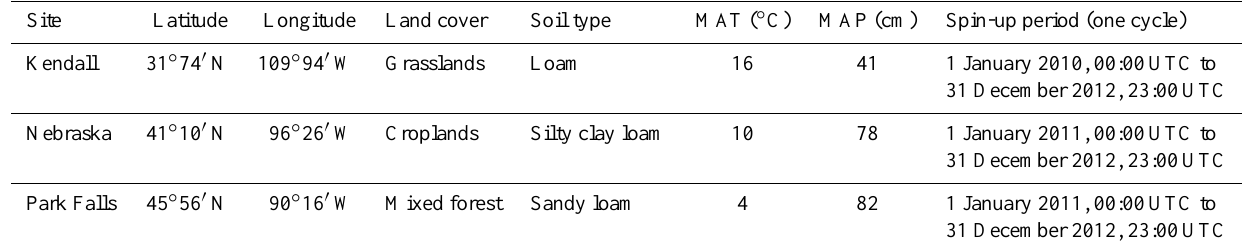
Table 1. Site information obtained from AmeriFlux database (http://ameriflux.lbl.gov). MAT = mean annual temperature, and MAP = mean annual precipitation. Notice the analyzed period in this study is a subset of the available data from each site and it is defined from 1 May 2012, 00:00UTC to 30 September 2012, 23:00UTC. Site Latitude Longitude Land cover Soil type MAT ( ◦ C) MAP (cm) Spin-up period (one